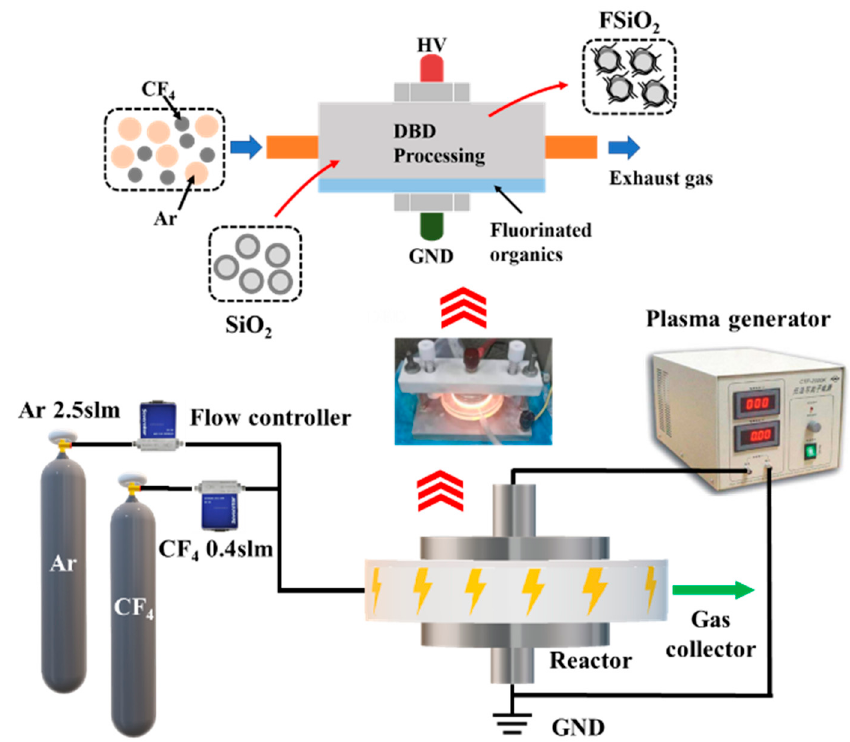
Figure 1. Plasma fluorination platform.